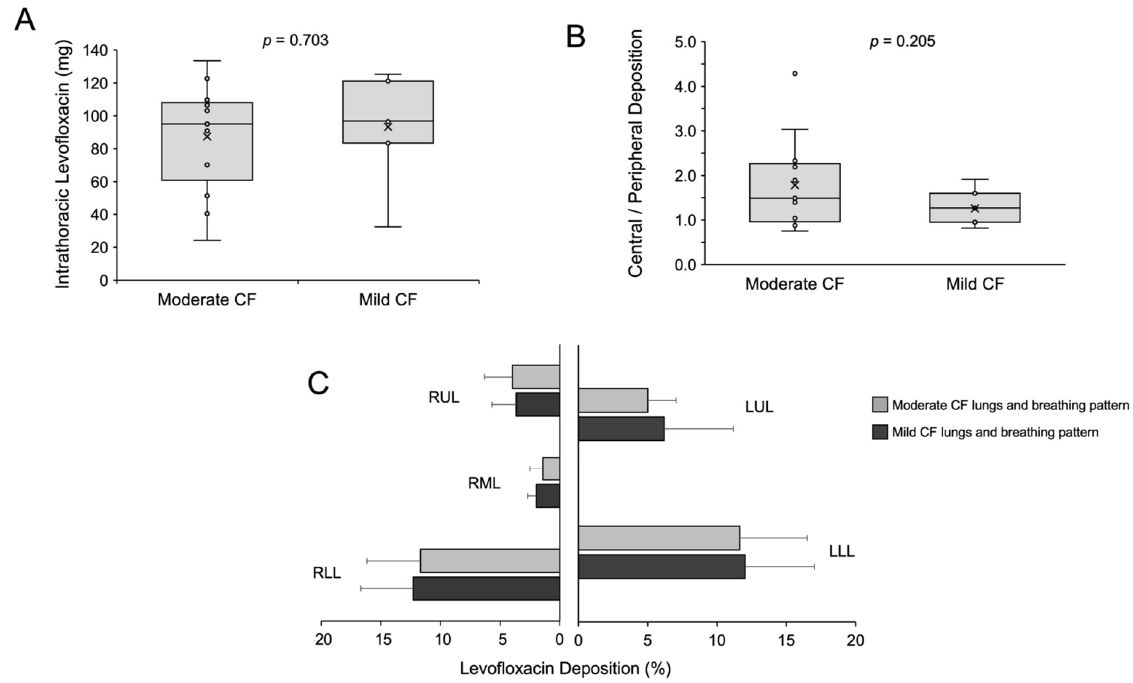
Figure 3. ( A ) Mean intrathoracic deposition in moderate and mild cystic fibrosis lungs. ( B ) Central to peripheral deposition (C/P) ratio in moderate and mild cystic fibrosis lungs. ( C ) Regional levofloxacin deposition in the moderate (light grey, n = 13) and mild (dark grey, n = 7) cystic fibrosis lungs. RUL, right upper lobe; RML, right middle lobe; RLL, right lower lobe; LUL, left upper lobe; LLL, left lower lobe.